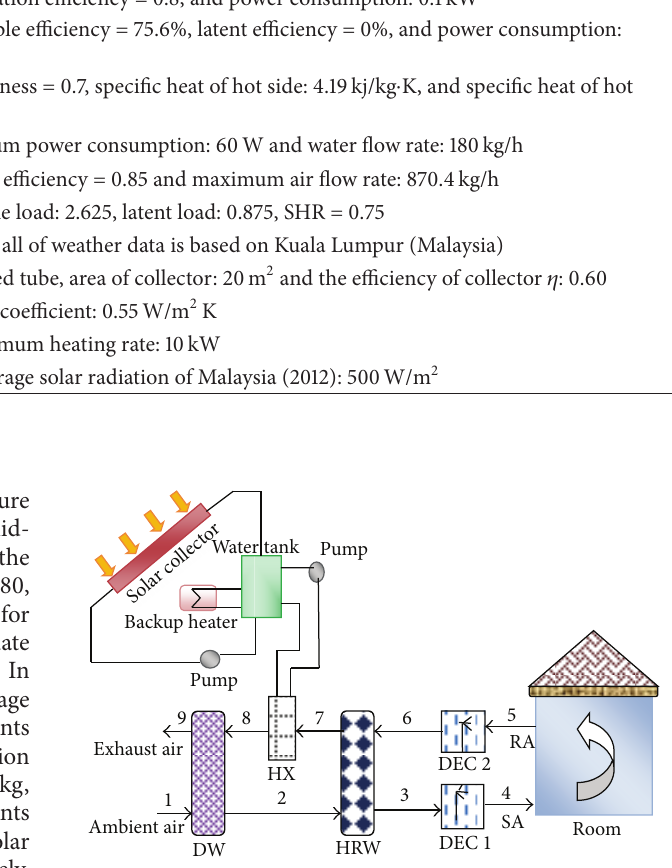
Figure 1: Solar desiccant cooling in ventilation mode schematic.